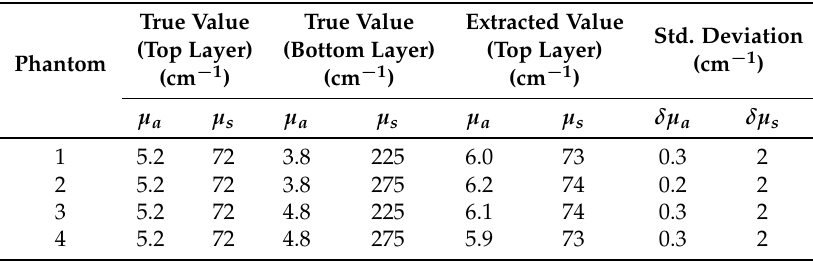
Table 4. Simultaneous recovery of absorption and scattering coefficients of the top layer from simulated data, when the bottom layer optical parameters are known with ∼ 10% error.